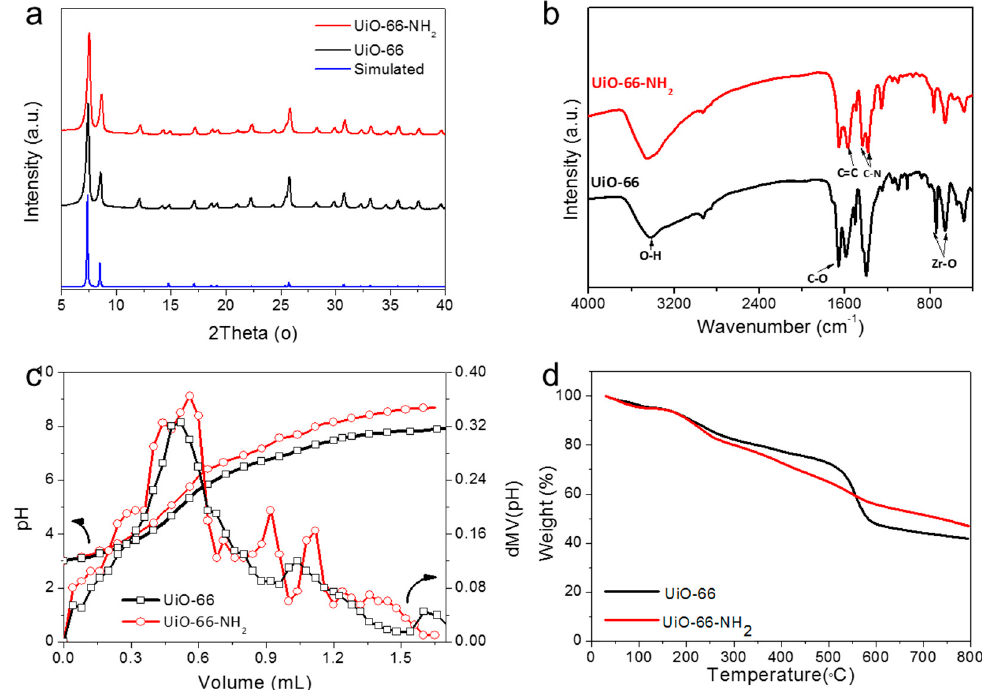
Figure 2. X-ray di ff raction patterns ( a ), FTIR spectra ( b ), acid-base titration curves ( c ), and TGA ( d ) Figure 2. X ‐ ray diffraction patterns ( a ), FTIR spectra ( b ), acid ‐ base titration curves ( c ), and TGA ( d ) curves of UiO-66 and UiO-66-NH 2 . curves of UiO ‐ 66 and UiO ‐ 66 ‐ NH 2 . Table 1. Calculated pKa’s and corresponding equivalence volumes for UiO-66 and UiO-66-NH 2 samples that were analyzed by acid-base Table 1. Calculated pKa’s and corresponding equivalence volumes for UiO ‐ 66 and UiO ‐ 66 ‐ NH 2 samples that were analyzed by acid ‐ base titration.